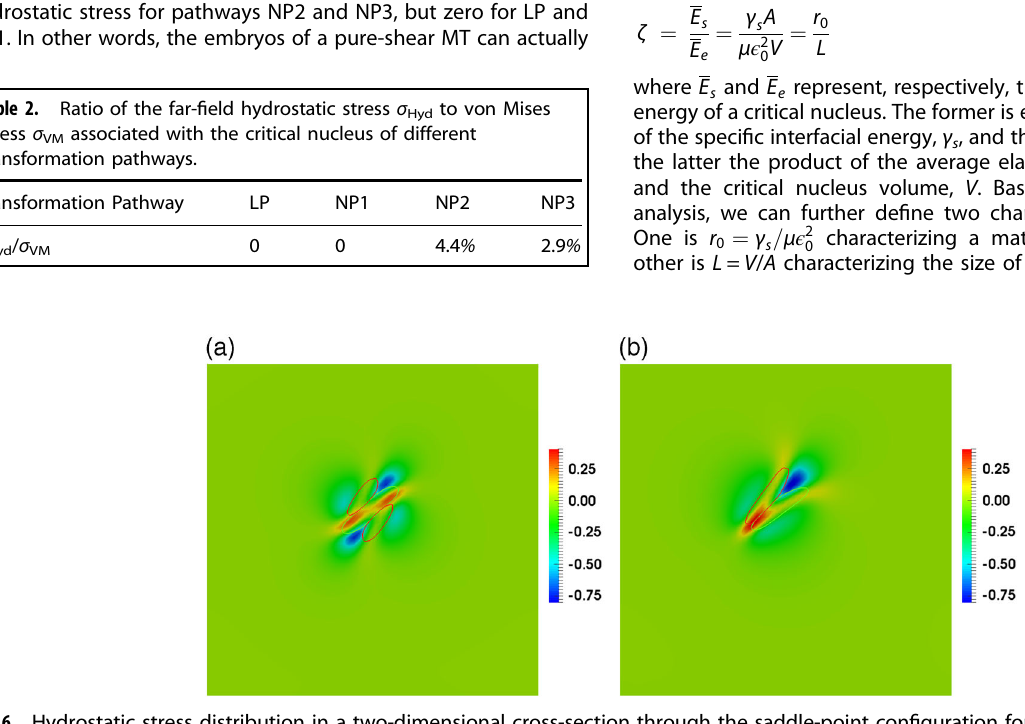
Fig. 6 Hydrostatic stress distribution in a two-dimensional cross-section through the saddle-point con fi guration for a LP (Fig. 5i) and b NP2 (Fig. 5k). Note that boundaries of two variants are represented, respectively, by closed green and red lines and colorbar is in reduced